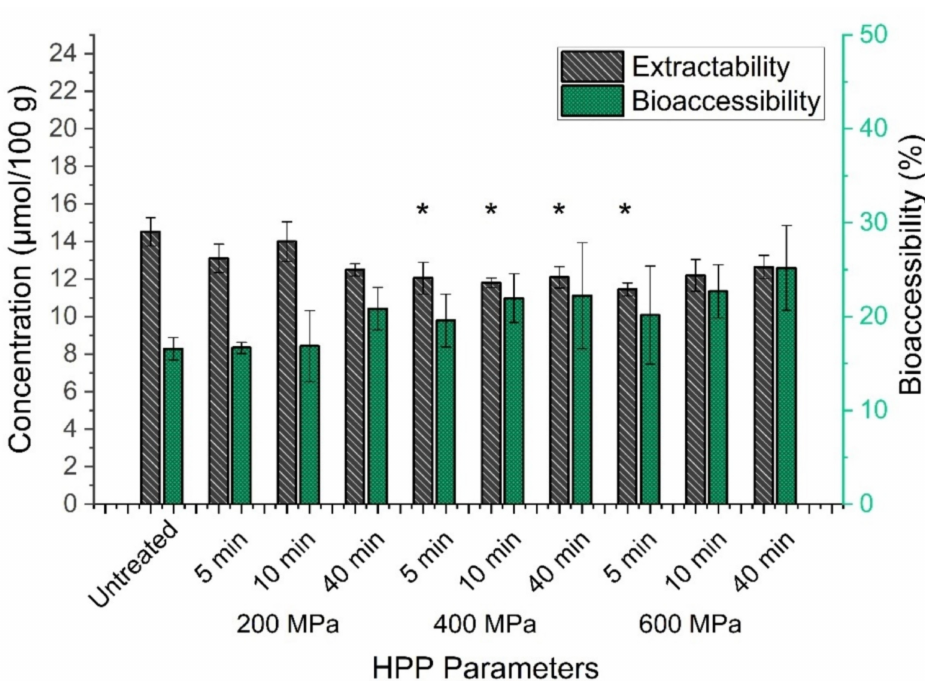
Figure 6. Comparison of extractability (grey bars in µ mol/100 g) and bioaccessibility (green bars in %) of (all-E)-lutein in untreated and HP-treated kale using different pressure parameters (200–600 MPa) and holding periods (5–40 min). One-way ANOVA with Tukey-HSD post hoc test; asterisks in the same line indicate significant differences ( p < 0.05) between treated and untreated samples. Table 4. Bioaccessibility of (all-E)- β -carotene and (all-rac)- α -tocopherol in untreated and HP-treated kale in dependence on HPP parameters (200–600 MPa with holding periods of 5 min, 10 min, and 40 min). Compound